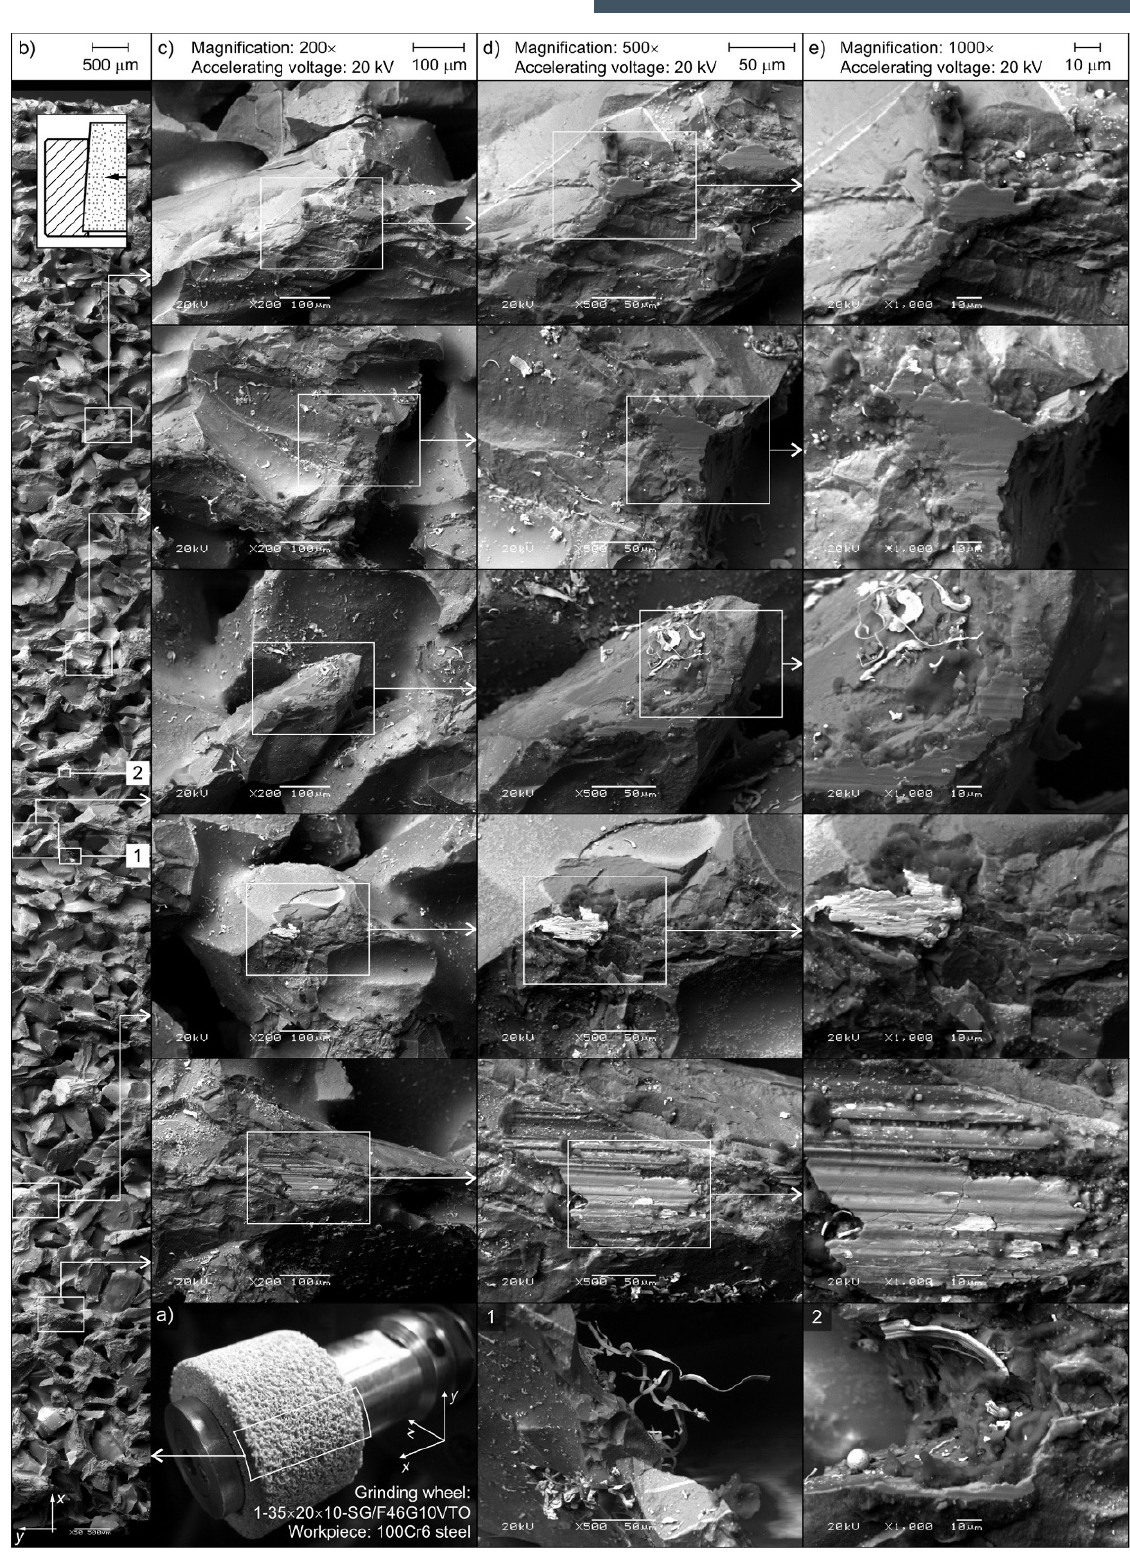
Figure 3. SEM microphotographs of the active surface of the conical grinding wheel after internal cylindrical plunge grinding of 100Cr6 steel: a) overall view of the tool; b) mag. 50 × ; c) mag. 200 × ; d) mag. 500 × ; e) mag. 1000 ×